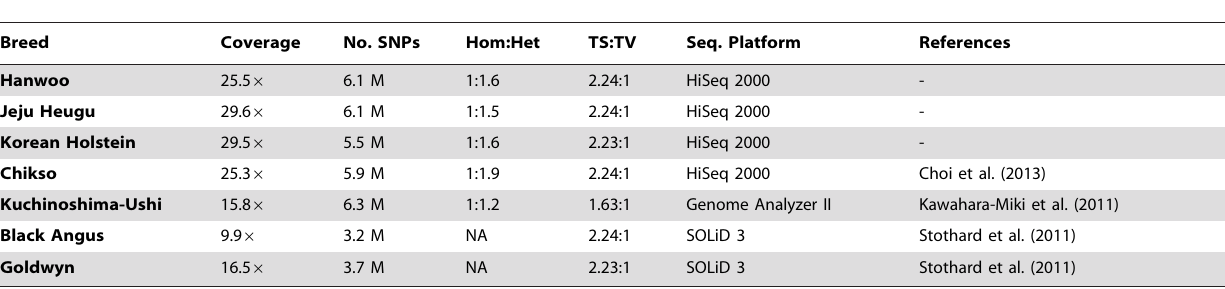
Table 3. Homozygous-to-heterozygous and transition-to-transversion ratios for the single nucleotide polymorphism (SNP)